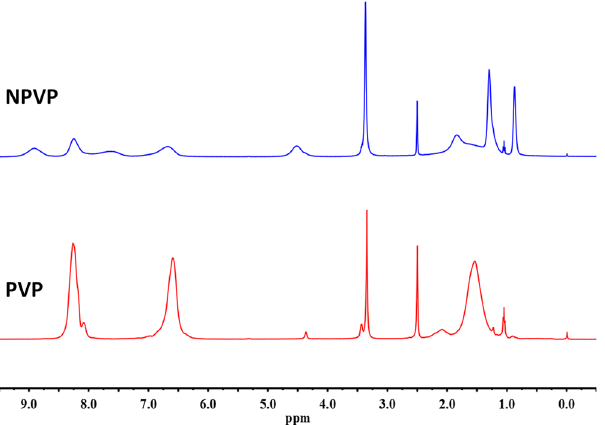
Figure 2. 1 HNMR spectra of PVP and NPVP. The peaks at 8.25 and 6.72 ppm were ascribed to the protons at the 2, 6 sites and 3, 5 sites of pyridine ring. After N-alkylation, they shifted to lower magnetic field of 7.68 and 8.91 ppm. Signal at 4.53 ppm was corresponding to the protons of the methylene groups bonded with N atom in the pyridine ring. The peaks from 1.31 to 1.86 ppm came from the aliphatic protons from the PVP backbone, the protons of methylene groups from alkyl bromides. The protons of methyl groups from alkyl bromides were observed in the high field of 0.88 ppm.